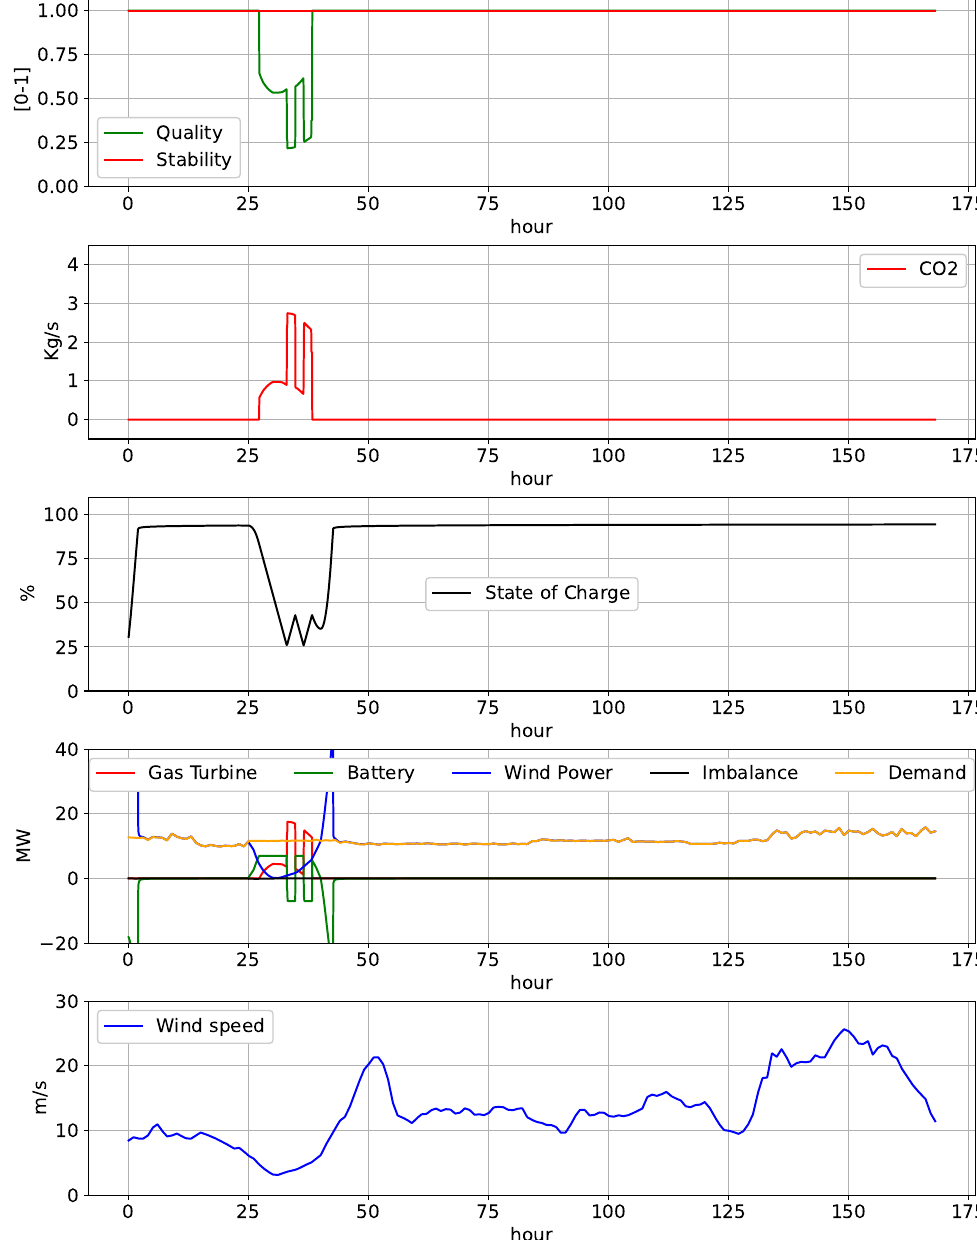
Figure 16. Strategy 1 with high wind speed